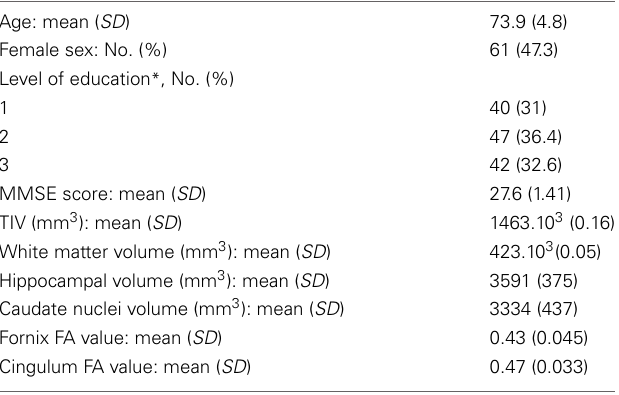
Table 1 | Characteristics of the sample ( n =